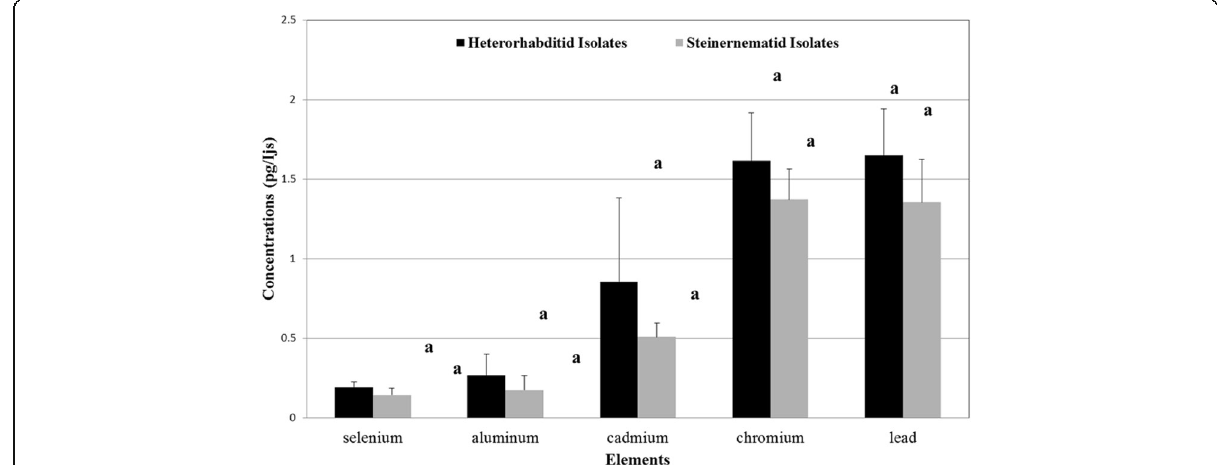
Fig. 2 Variations of lead, chromium, cadmium, aluminum, and selenium contents (mean ± SD) between the infective juveniles of heterorhabditid and steinernematid isolates (adjacent bars with the same letter are not significantly different, P >